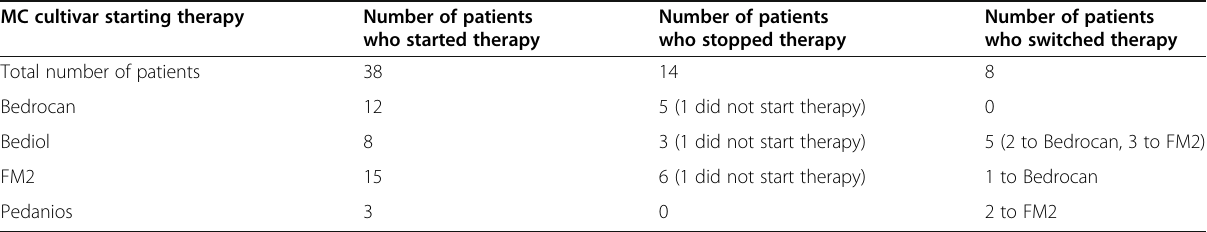
Table 5 Types of medical cannabis cultivars first prescribed to 38 Italian patients with fibromyalgia syndrome MC cultivar starting